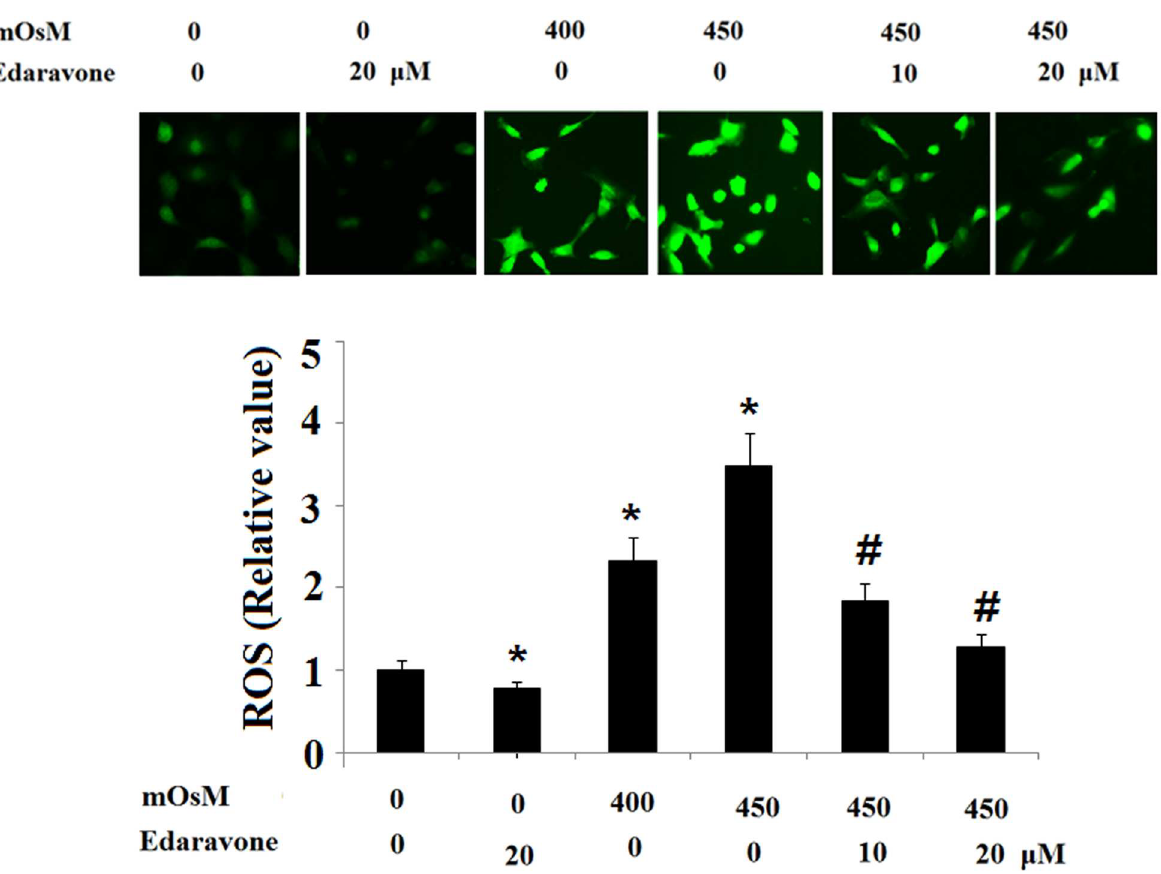
Fig 1. Suppressive effects of edaravone on ROS in primary HCEpiCs exposed to hyperosmotic media. ROS was evaluatedvia DCFH-DA staining (ANOVA: * , P < 0.001vs. untreated control; #, P < 0.001vs. 450 mOsM treated